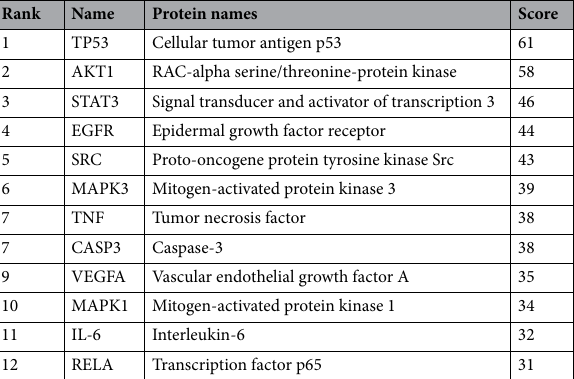
Table 1. Top 12 high-degree genes in the